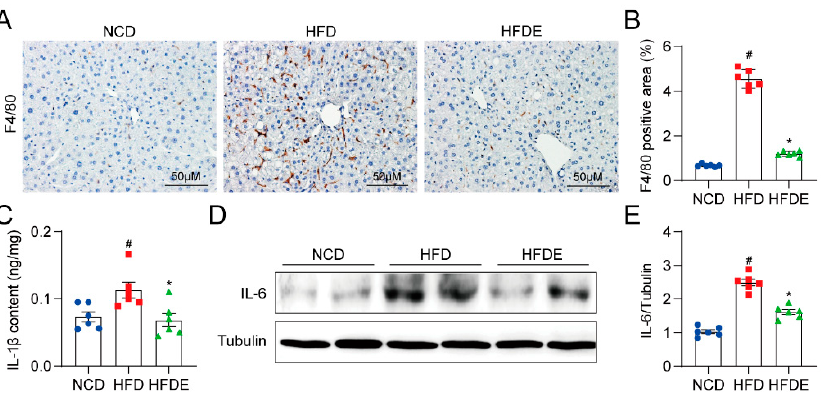
Figure 3. Exercise decreases inflammation in mouse livers. ( A ) Representative F4/80 immunohistochemical staining of liver sections (200 × ). ( B ) Quantification of F4/80-positive area in immunohistochemical staining. ( C ) Cytokine levels of inflammation marker IL-1 β in mouse liver tissues. ( D , E ) Protein levels of inflammation marker IL-6 in mouse liver tissues. Tubulin was used as the loading control. The data are presented as the mean ± SEM, n = 6 per group. # p < 0.05 vs. NCD group; * p < 0.05 vs. HFD group .